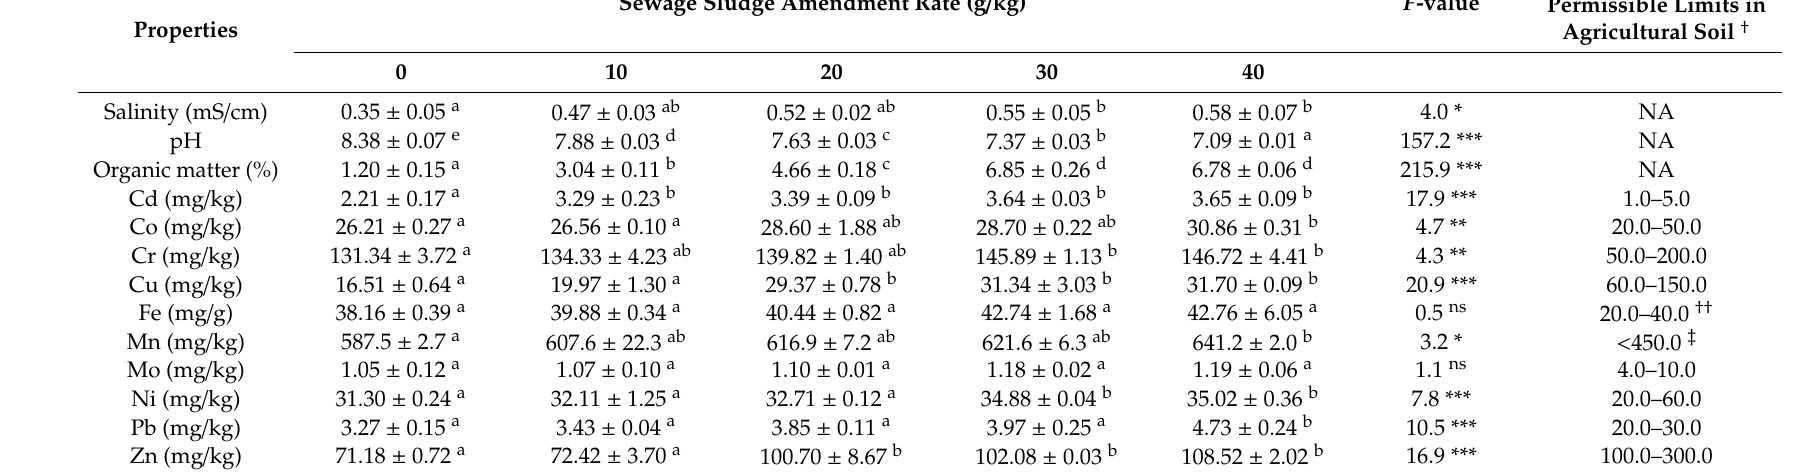
Table 2. Selected chemical properties of soil at di ff erent sewage sludge amendment rates after harvesting Pisum sativum that had been grown for 57 days (means ± standard error, n =